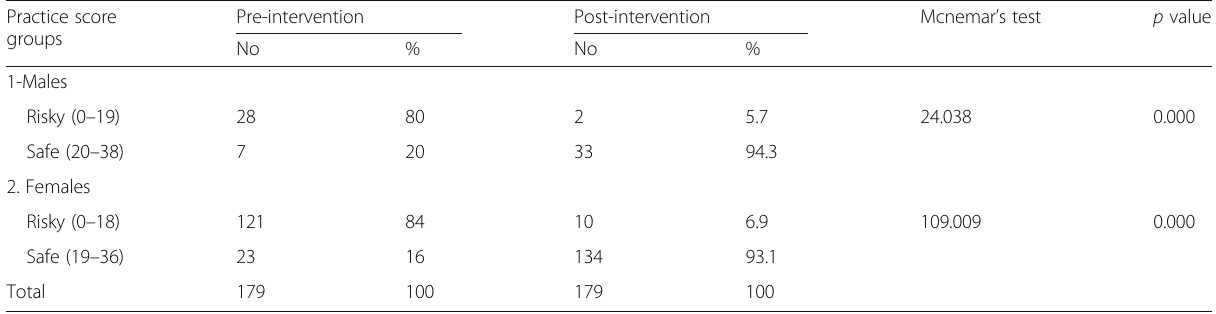
Table 4 Effect of health education intervention on study male and female participant ’ s total score of practice about HCC and its risk factor prevention Practice score